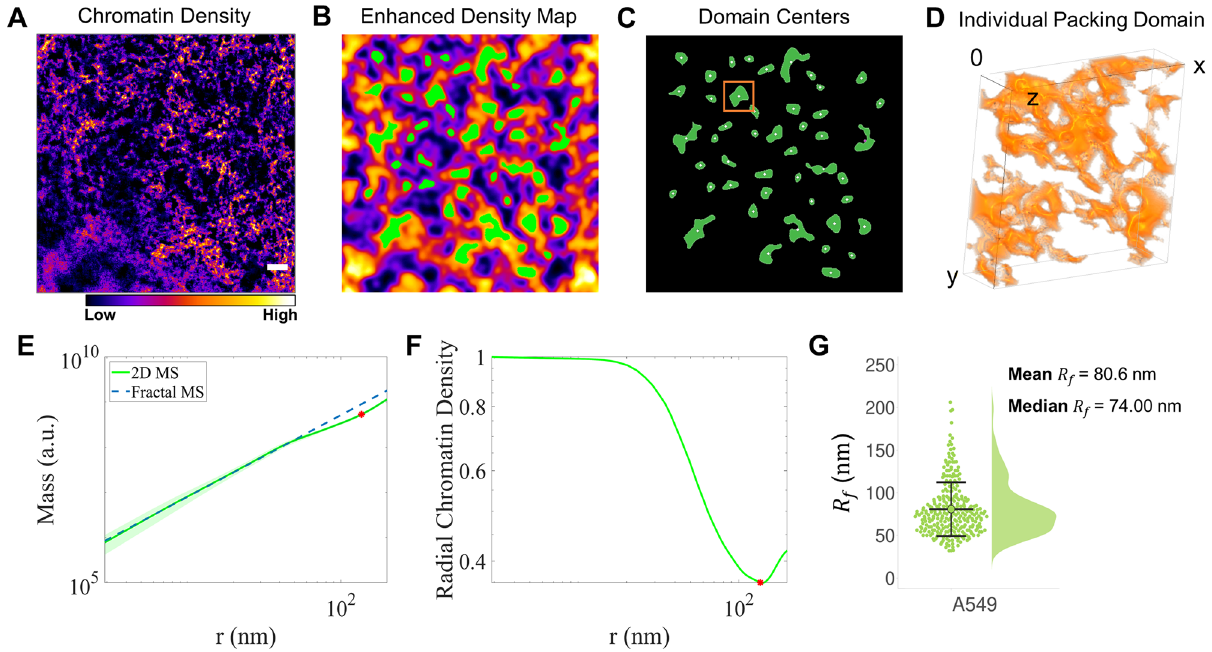
Figure 3. Quantifying domain size and chromatin packing behavior at the domain boundaries. Chromatin packing domains are structurally heterogeneous and anisotropic. ( A ) ChromSTEM grayscale tomogram for one field of view of an A549 cell. The color bar represents chromatin mass density. ( B , C ) Local chromatin maxima map estimated from enhanced chromatin density projection shown in ( B ) was utilized to find chromatin domain centers shown in ( C ). ( D ) 3D rendering of the surface of chromatin density in a region containing the packing domain of interest (orange square in C ). (E) The average 2D mass scaling curve of the chromatin domain within the region of interest (orange square in C ). For one domain, the mass scaling curve is resampled from all loci within the domain center identified in ( C ). The mass scaling analysis is conducted starting from the domain center. The MS curve starts with D < 3 (blue dashed line) and transitions to values closer to D = 3 beyond the potential domain boundary (red asterisk at 110 nm). ( F ) Radial distribution of chromatin density or radial CVC for the same domain. The radial CVC initially decreases slowly within the domain regime. As the length scale approaches the potential domain boundary (red asterisk at 130 nm), the radial CVC rapidly dips which is followed by a recovery, due to the presence of other domains at those length scales. ( G ) The distribution of R f , the radius of packing domains, for A549 cells. The mean R f is 80.6 nm, and the median along with the lower and upper quartile is 74 (58–93)